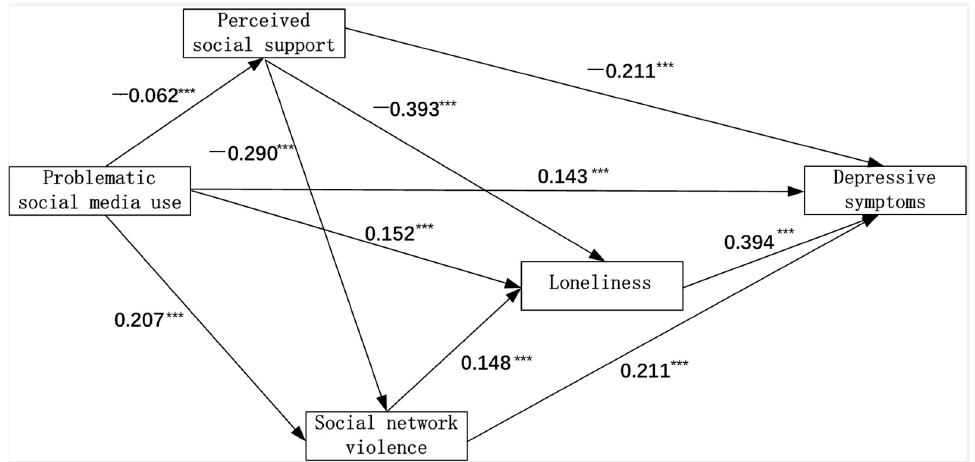
Figure 3. The mediating effects of perceived social support, social media violence, and loneliness on the associations between problematic social media use and depressive symptoms among college students in Shaanxi, China. (Sex and grade were adjusted in this mediation model. RMSEA = 0.065, GFI = 0.984, CFI = 0.982.). ***: p < 0.001. Table 4. Mediating effects of perceived social support, loneliness, and social media violence on the associations between problematic social media use and depressive symptoms among college students in Shaanxi,